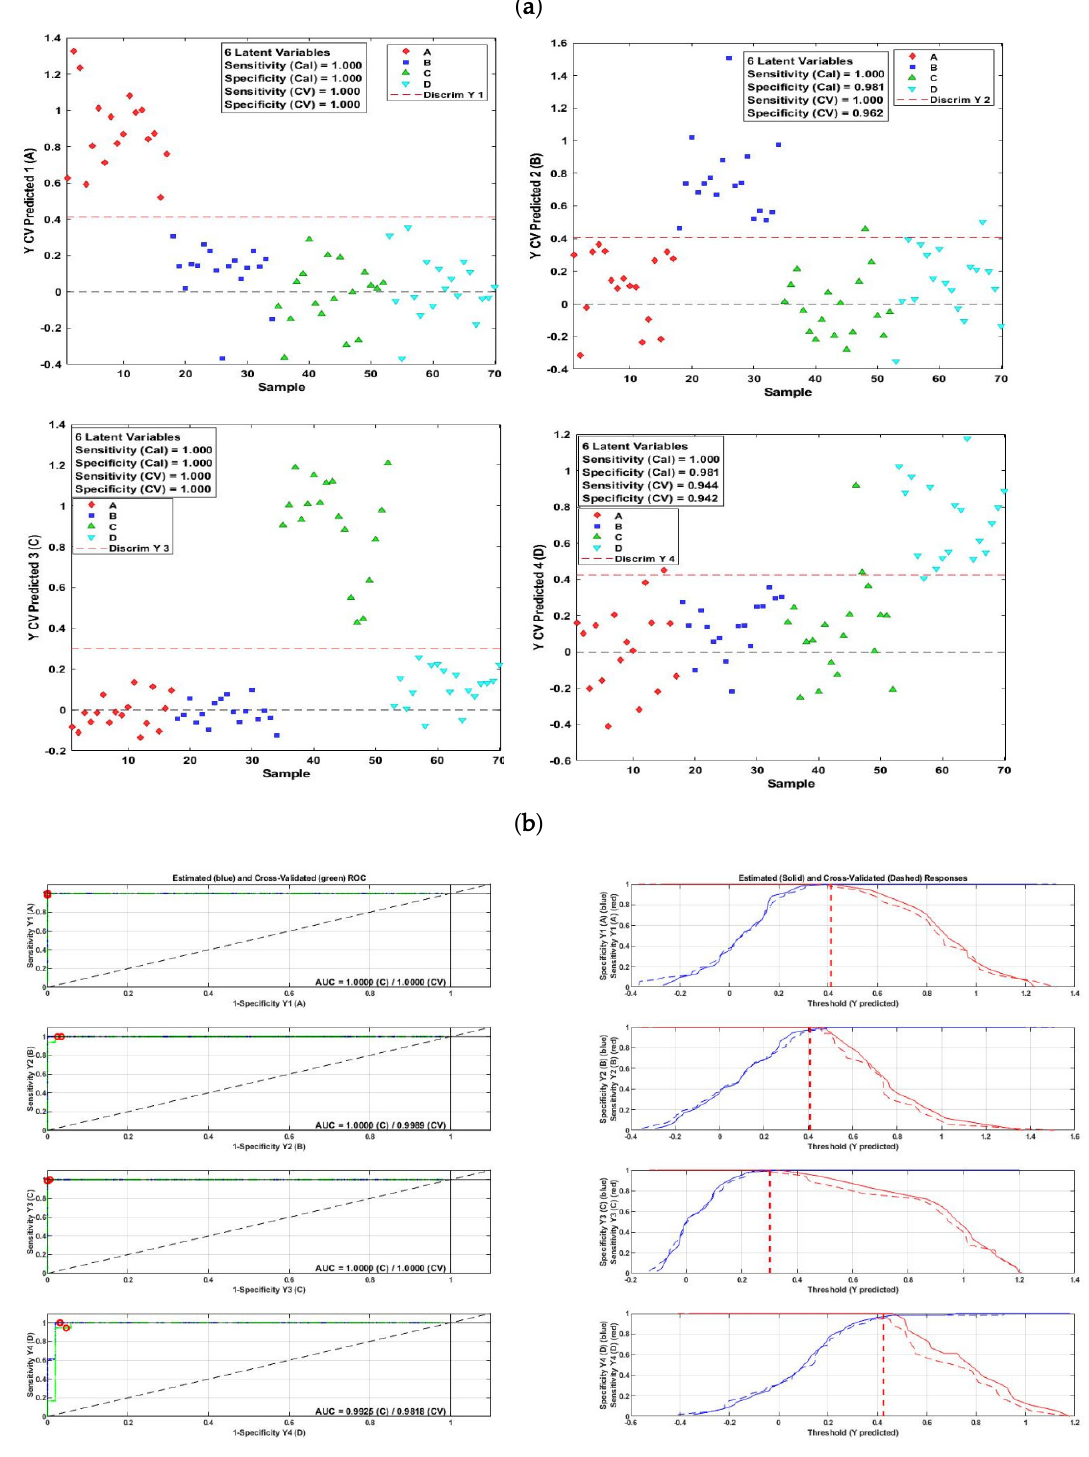
Figure 4. Partial least square discriminant analysis (PLS-DA) results obtained from the fluorescence measurements of the four lutefisk brands: Cross-validated predicted brand (a) and ROC plots (b). ROC plots on the right-hand side of the Figure 4b show similar information in a different format; the plots represent the choice of the decision threshold to obtain optimal combination of sensitivity and specificity values. The point at which sensitivity and specificity meet is the balance between false